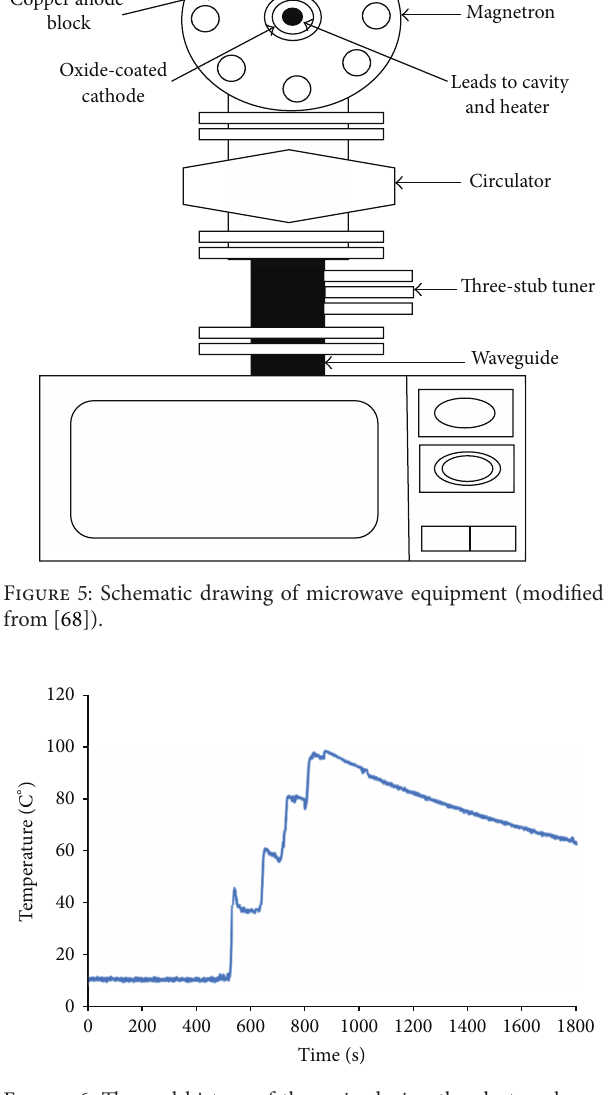
Figure 6: Thermal history of the resin during the electron beam (EB) curing of the composite laminate